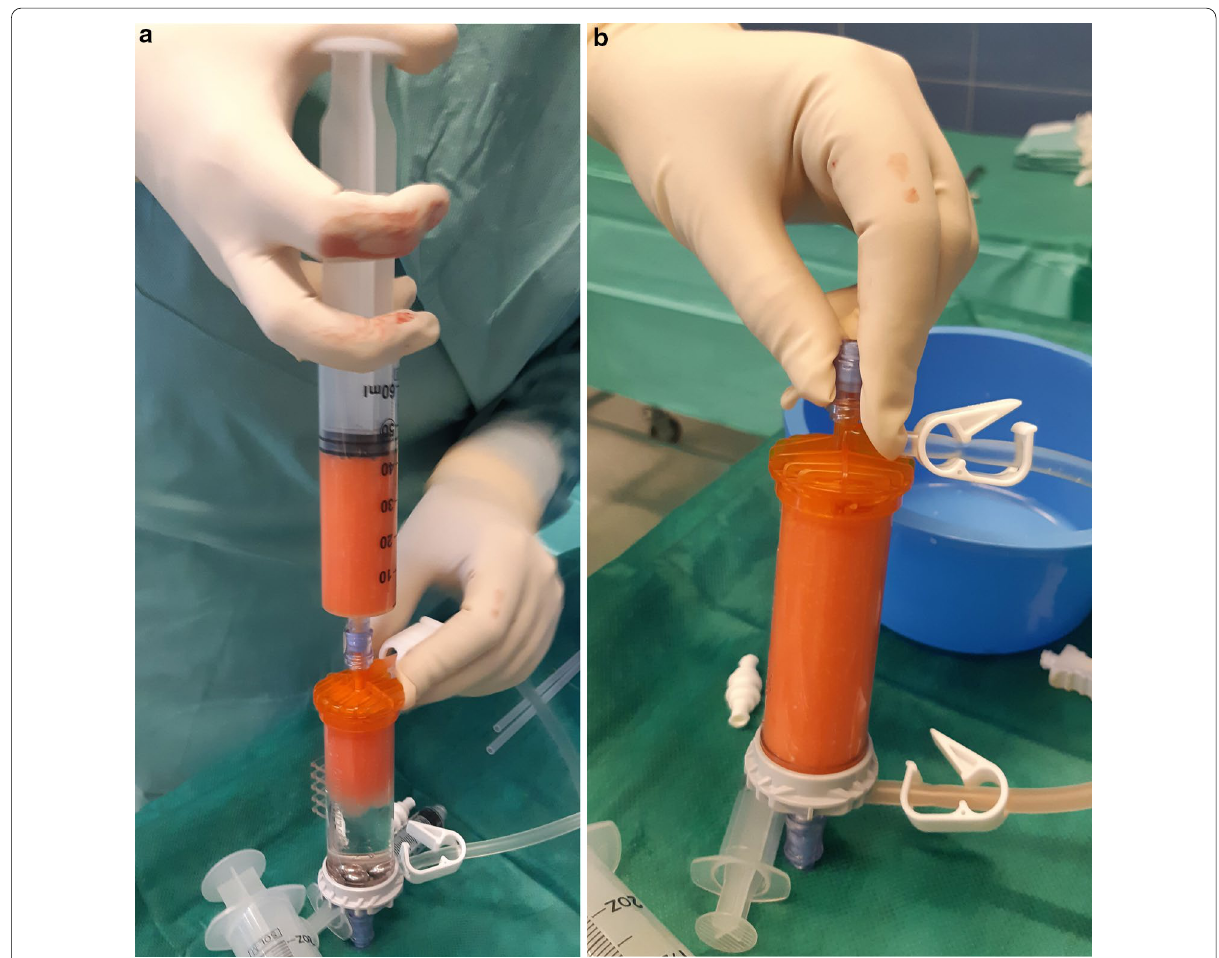
Fig. 3 The harvested fat is transferred into the Lipogems ortho kit ( a , b ) to microfragment the adipose tissue (and activate the ASCs) and to wash it through a saline